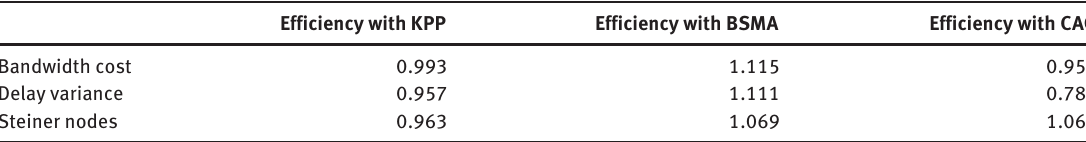
Table 6. Efficiency of the Proposed